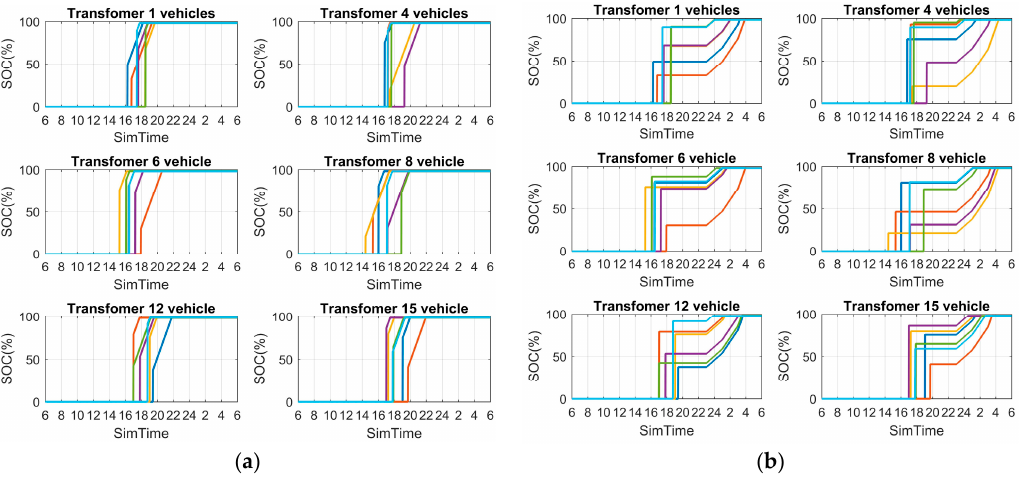
Figure 6. PEV charging paths under distribution transformers on phase C. ( a ) Uncontrolled PEV charging paths; and ( b ) PEV charging paths with ToU + direct load control (DLC) method.